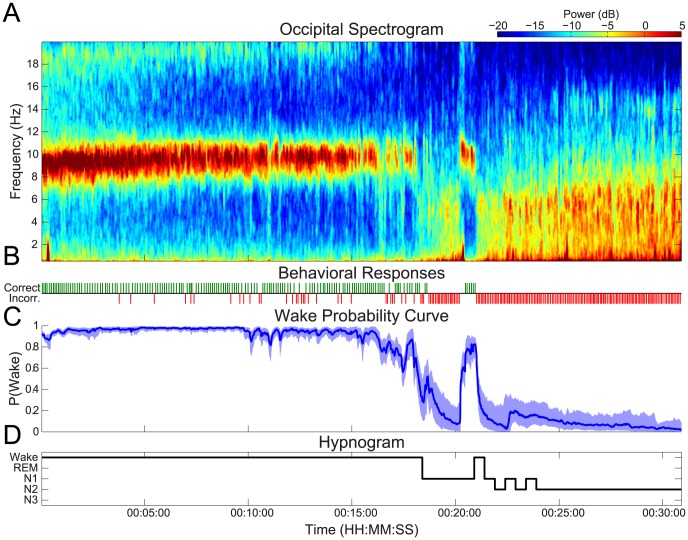
Tracking a fragmented SOP. A comparison of the (A) spectrogram, (B) behavioral responses, (C) the wake probability curve, (D) and the clinical hypnogram.In (C), the distribution median (curve), and 95% confidence intervals (shaded region) are shown. The probability of wakefulness tracks both the gradual time course of the initial descent into sleep, as well as the rapid changes during the arousal period.